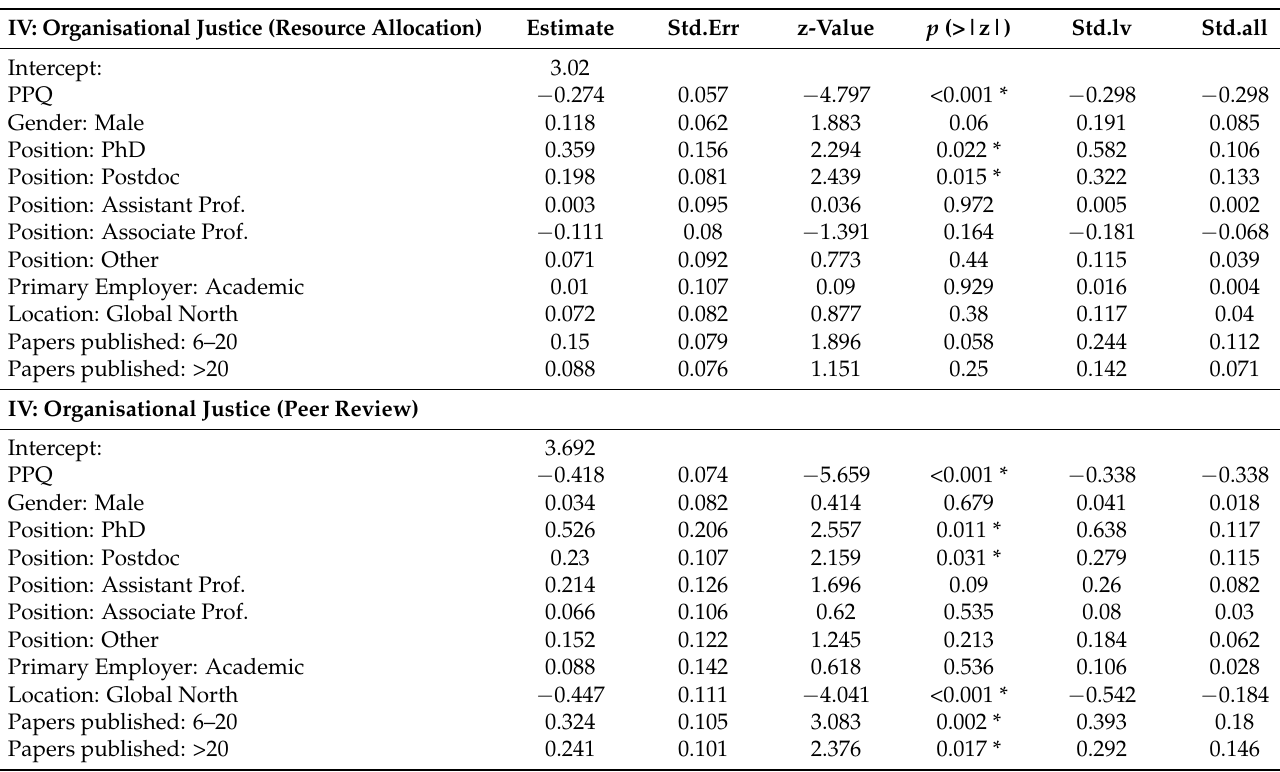
Table 5. Extracted output for the four forms of the independent variable “Organisational Justice” from the regression analysis of our SEM model. * indicates statistical significance ( p <